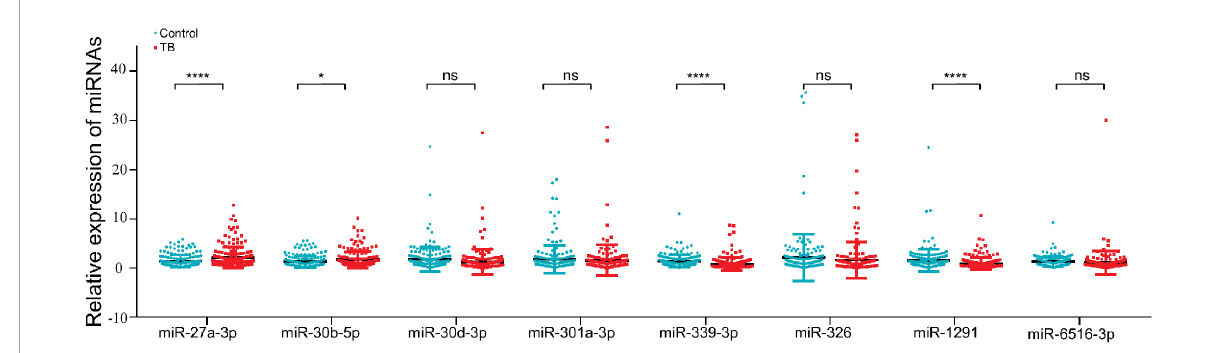
FIGURE2 MiR-27a-3p and miR-30b-5p expression was higher in the tuberculosis group than in the control group. The qRT–PCR was used to validate the eight upregulated miRNAs (181 TB patients, 179 control individuals). MiR-27a-3p and miR-30b-5p were highly expressed in the TB group. The expression of four miRNAs (miR-30d-3p, miR-301-3p, miR-326, and miR-6516-3p) was not different between the TB group and the control group, and the remaining two miRNAs (miR-339-3p and miR-1291) were low expressed in the TB group. * P < 0.05, ** P < 0.01, *** P < 0.001, **** P < 0.0001, ns = not significant.